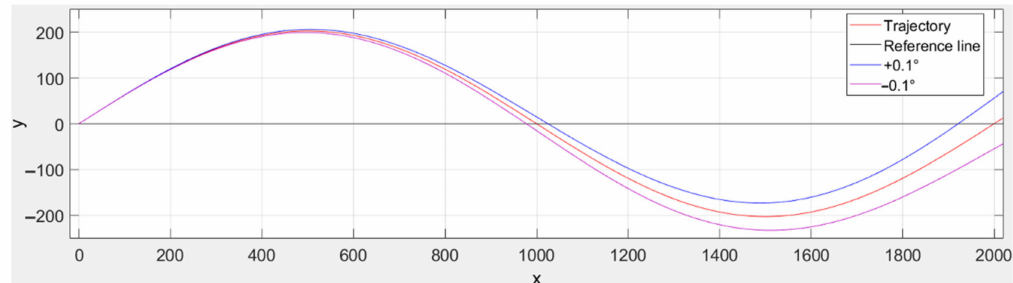
Figure 9. Error type I simulation.